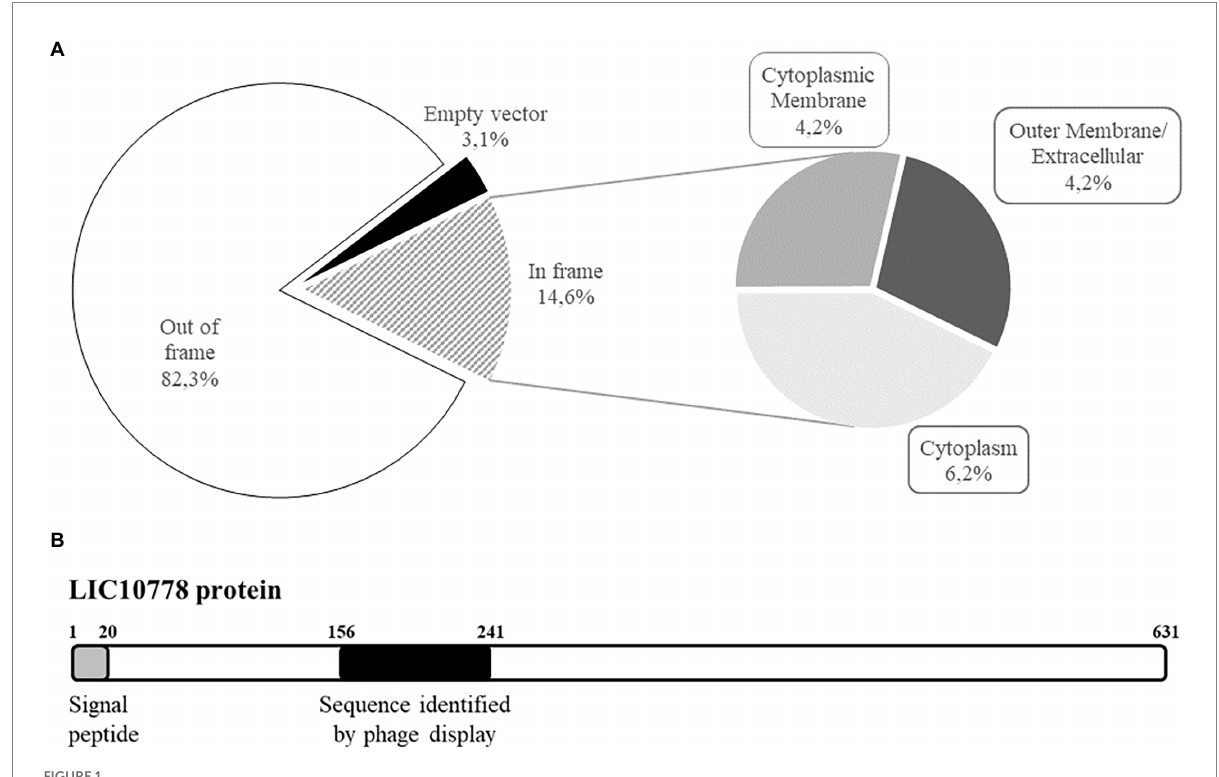
FIGURE 1 Shotgun phage display led to the identification of LIC10778 protein. (A) Classification of shotgun library phages bound to kidney epithelial cells (VERO) along three rounds of selection using BRASIL methodology. Samples were evaluated by alignment (BLASTx) and by determination of the six possible reading frames (EMBOSS Transeq). Subsequently, clones were classified based on the presence of Leptospira interrogans sequences displayed “In frame” or “Out of frame” with pVIII bacteriophage protein. Clones that lacked L. interrogans sequences were classified as “Empty vector.” In-frame clones were further classified according to their predicted subcellular location in leptospires: “Cytoplasmic membrane,” “Outer membrane/Extracellular,” or “Cytoplasm.” (B) Schematic representation of LIC10778 protein, showing the predicted signal peptide and the sequence identified by phage display, both located at the N-terminal region of the